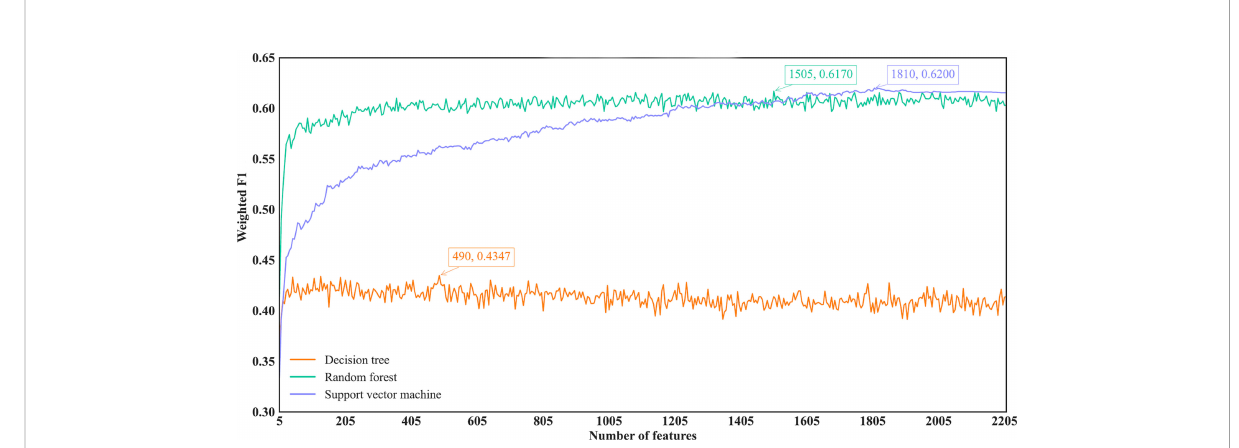
FIGURE 5 IFS curves of different classi fi cation algorithms on the mRMR feature list. Three classi fi cation algorithms provided highest weighted F1 values of 0.4347, 0.6170 and 0.6200, respectively, based on top 490, 1505 and 1810, respectively, features in the list.